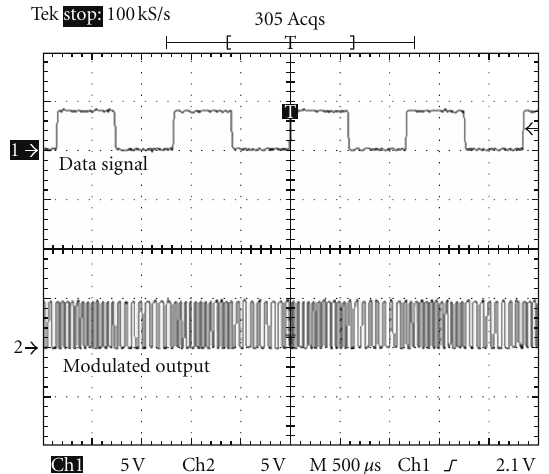
Figure 12: Amplified data signal and FSK output from the modu- lator unit.